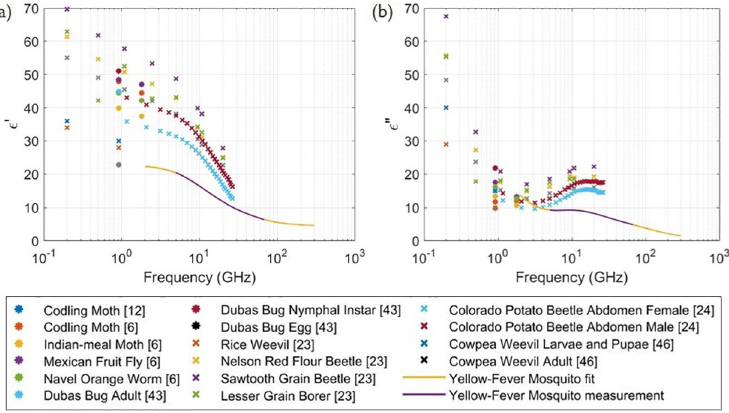
Fig 7. (a) Real and (b) imaginary part of relative permittivity. Given for insects in other studies [6, 12, 23, 24, 43, 45, 46] and for the yellow fever